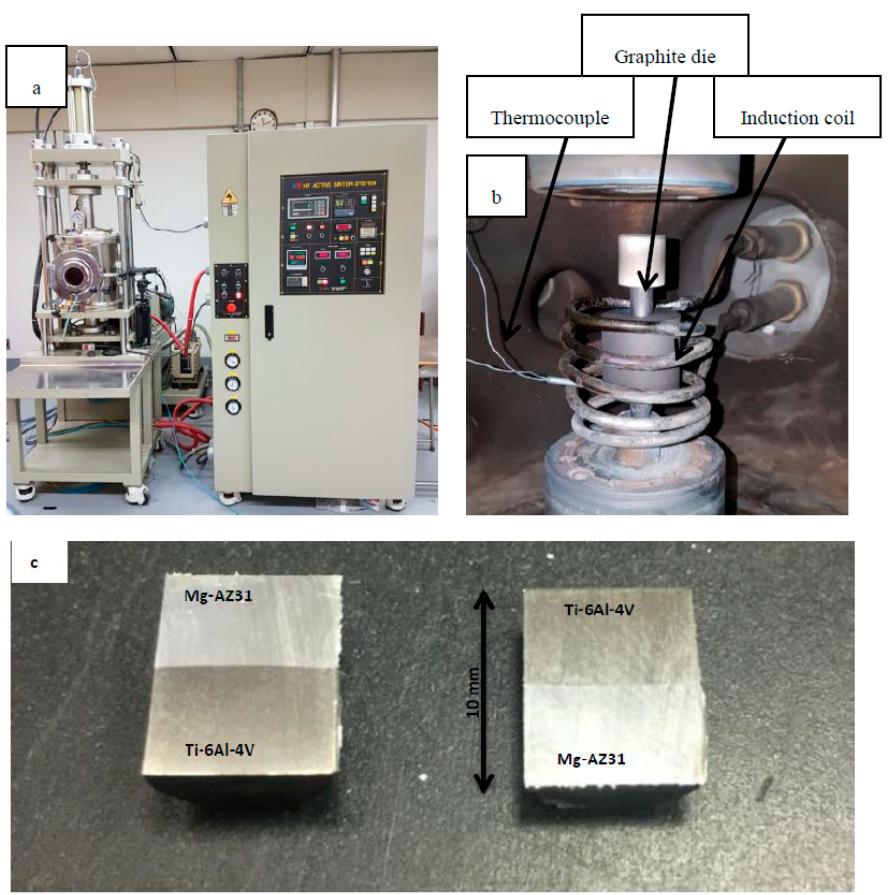
Figure 1. Photos of ( a ) high-frequency induction heating sintering (HFIHS) machine used for